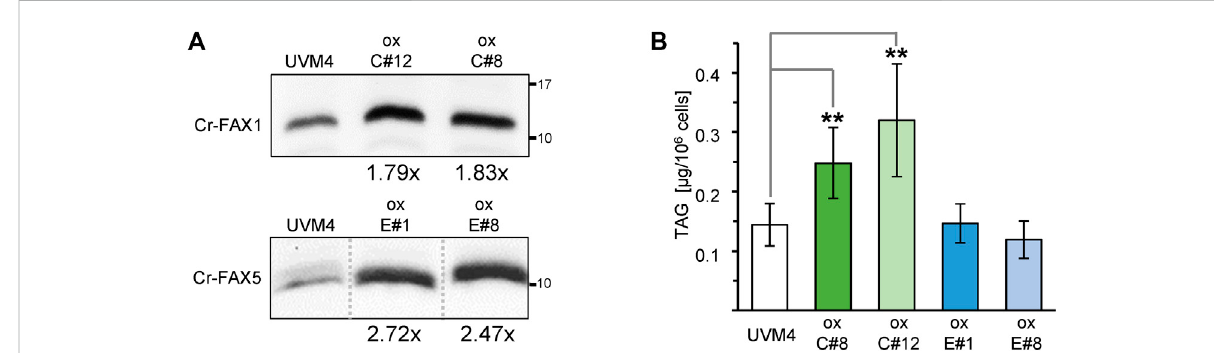
FIGURE 6 Overexpression of Cr-FAX1 affects oil content in Chlamydomonas. (A) Overexpression of Cr-FAX1, Cr-FAX5 in UVM4 C. reinhardtii cells. Immunoblot analysis of Cr-FAX1 (top) and Cr-FAX5 (bottom) in protein extracts from Chlamydomonas cells that were transformed with overexpression constructs for Cr-FAX1 (ox-C) and Cr-FAX5 (ox-E) under control of the constitutive PSAD promoter (see Figure 1B). Proteins were extracted from cells of independently derived Cr-FAX1ox strains C#12, C#8 (top) and Cr-FAX5ox strains E#1, E#8 (bottom) as well as the respective untransformed, parental strain UVM4. Equal amounts of proteins (isolated from the same quantity of cells corresponding to 2 μ g chlorophyll) were separated by SDS-PAGE and subjected to immunoblot analysis using antisera directed against Cr-FAX1 or Cr-FAX5. Numbers indicate molecular mass of proteins in kDa. The increase in protein amount compared to UVM4 could be estimated to be around 1.8-fold for both Cr-FAX1oxC#8(1.83±0.13),C#12(1.79±0.16)andat2.7-fold,2.5-foldforCr-FAX5oxE#1(2.72±0.38)andE#8(2.47±0.07),respectively(n=3 – 4 independentimmunoblots±SD).Notethatallboxedimmunoblotsignalsweregeneratedononeidenticalblot(seeSupplementaryTableS7).Signals ofothermutantlines,whicharenotsubjectofthisstudy,havebeenremovedasindicatedbygray,dottedlines. (B) OverexpressionofchloroplastCr- FAX1 increases TAG oil contentin Chlamydomonas cells. Two independently generated C. reinhardtii strains (see (A) )each for overexpressionof Cr- FAX1: lines ox-C#8 (green) and ox-C#12 (light green), and Cr-FAX5: lines ox-E#1 (blue) and ox-E#8 (light blue) as well as the respective wild-type parental strain UVM4 (white) were grown in TAP medium and harvested in the exponential growth phase for determination of neutral lipids via TLC. TAG neutral lipids [ μ g/10 6 cells] were quanti fi ed densitometrically after separation by TLC from fi ve individual liquid cultures of each strain (n = 5 ± SD). p -values for signi fi cantly different TAG contents when compared to UVM4 are indicated (double-sided student t-test): ** p <